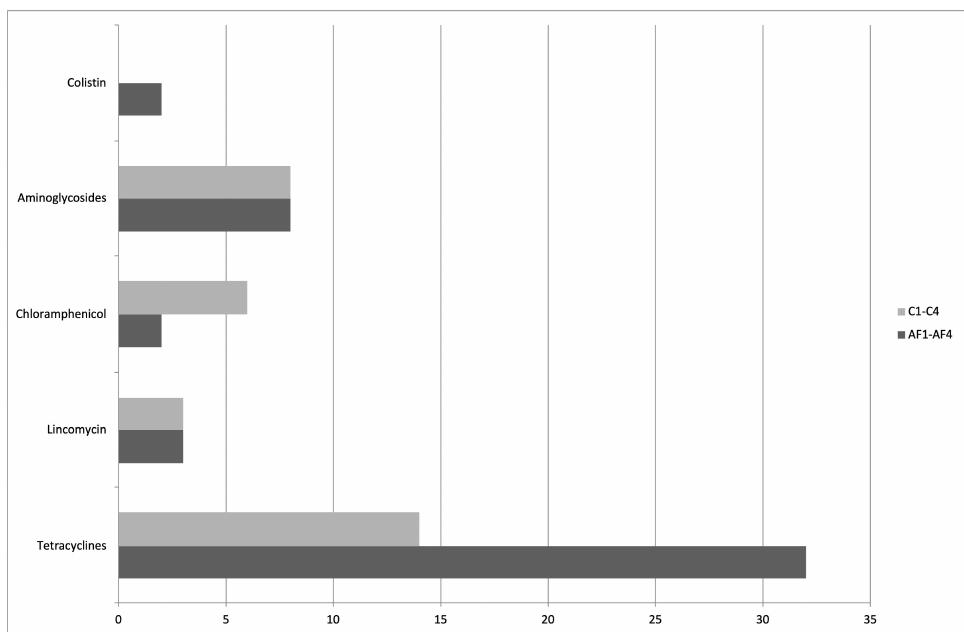
Figure 1. Total ARGs fragments amplified by PCR test, grouped by antibiotic classes and types of farming. The frequency of all target fragments was obtained by summing the number of PCR tests that returned a positive result from each ARG and litter sample. Table 1. Distribution of investigated ARGs in conventional and antibiotic-free flocks. Farms ARG Litter